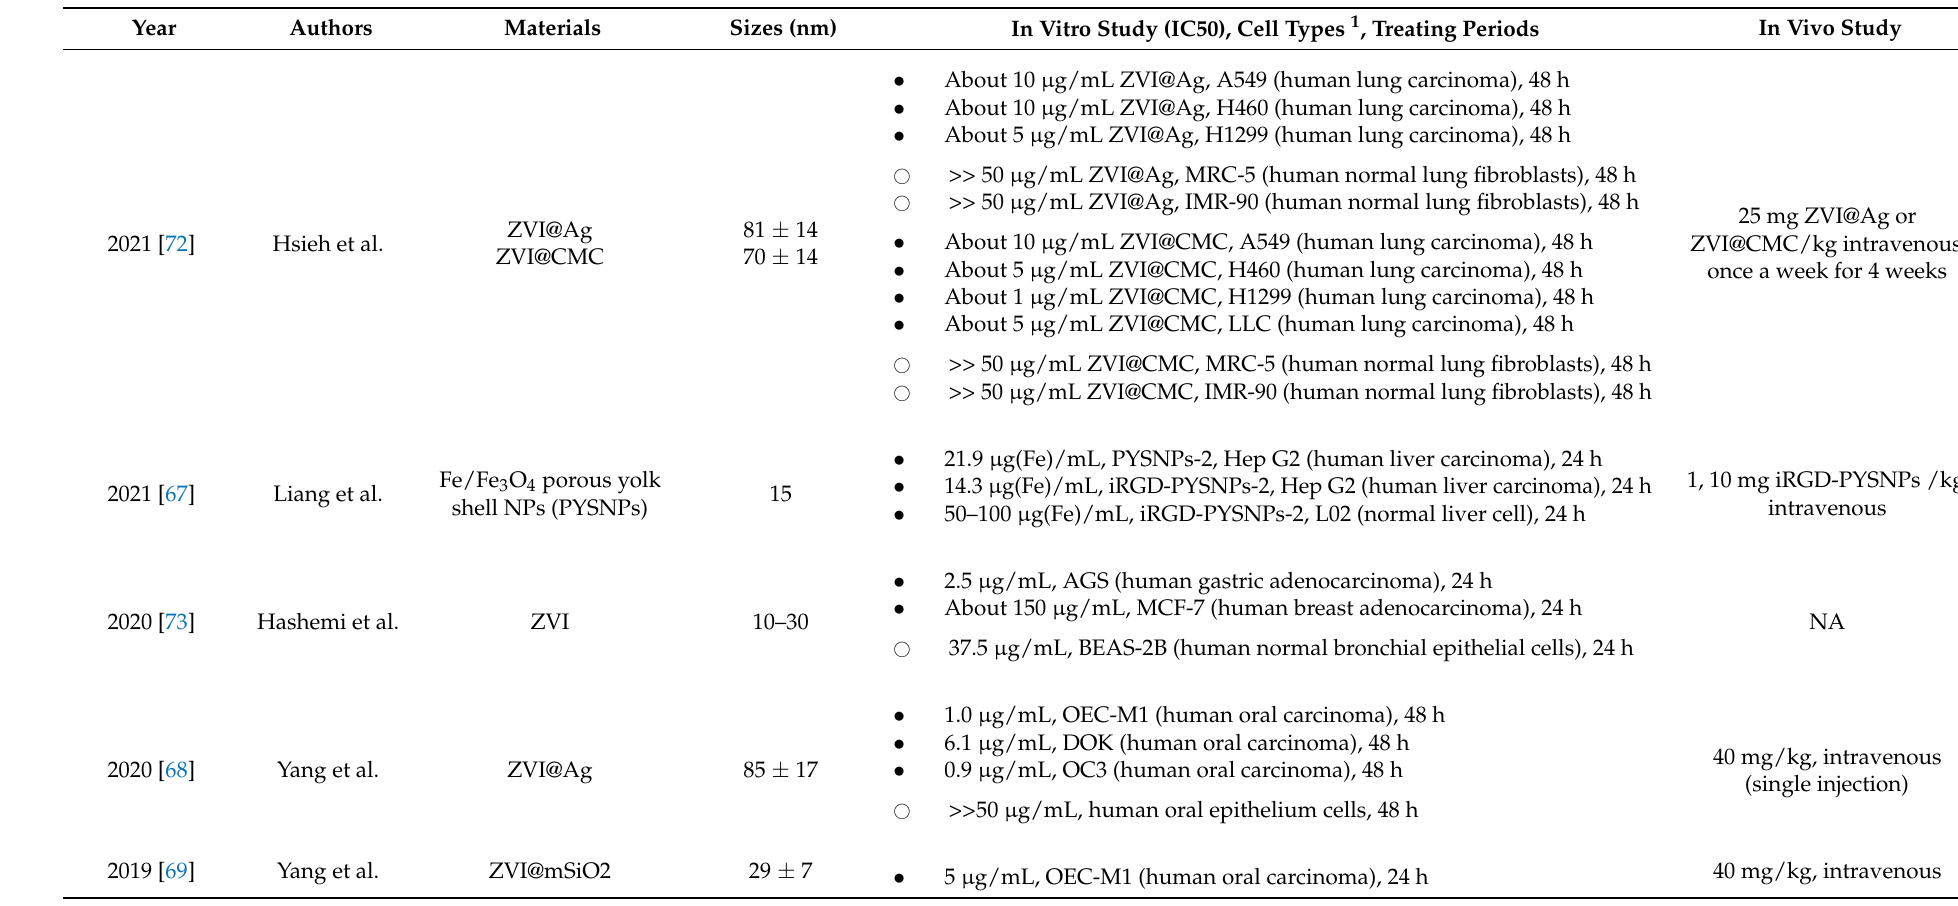
Table 1. The anti-cancer activity of ZVI based NPs in vivo and in